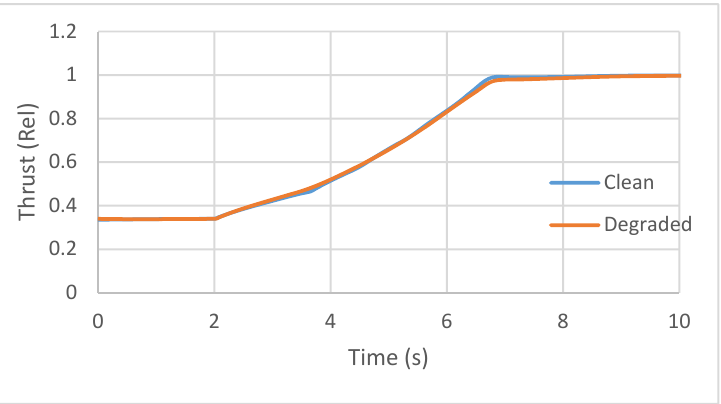
Figure 25. Comparison of the thrust of the clean engine with the clean controller and the degraded engine with the adjusted controller.